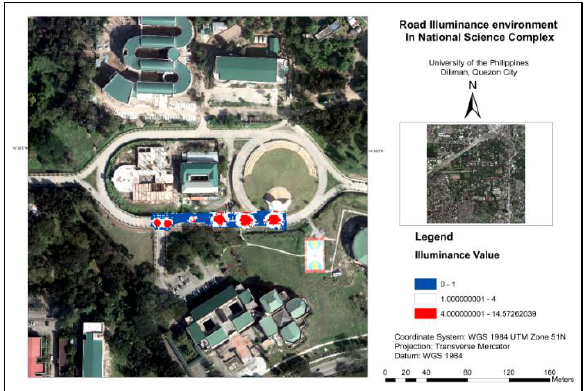
Figure 18. 2D Illuminance mapping of the road area using linear function channel